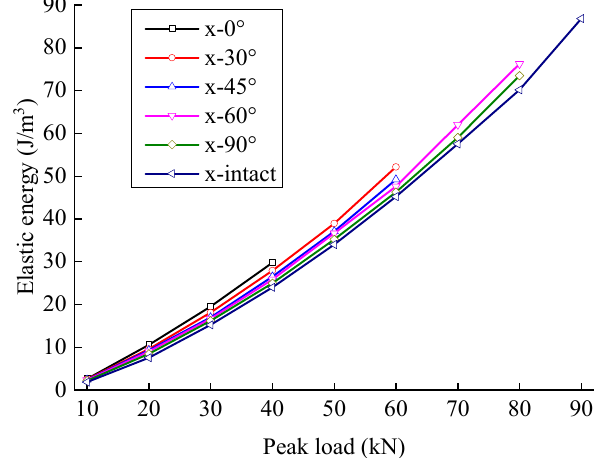
Figure 9. Elastic energy evolution curve of sandstone with different crack angles.